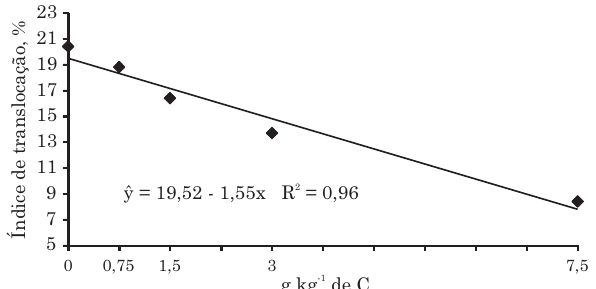
Figura 3. Índice de translocação de chumbo em plantas de milho em função de doses de carbono aplicadas ao solo via substâncias húmicas e carvão vegetal ativado.